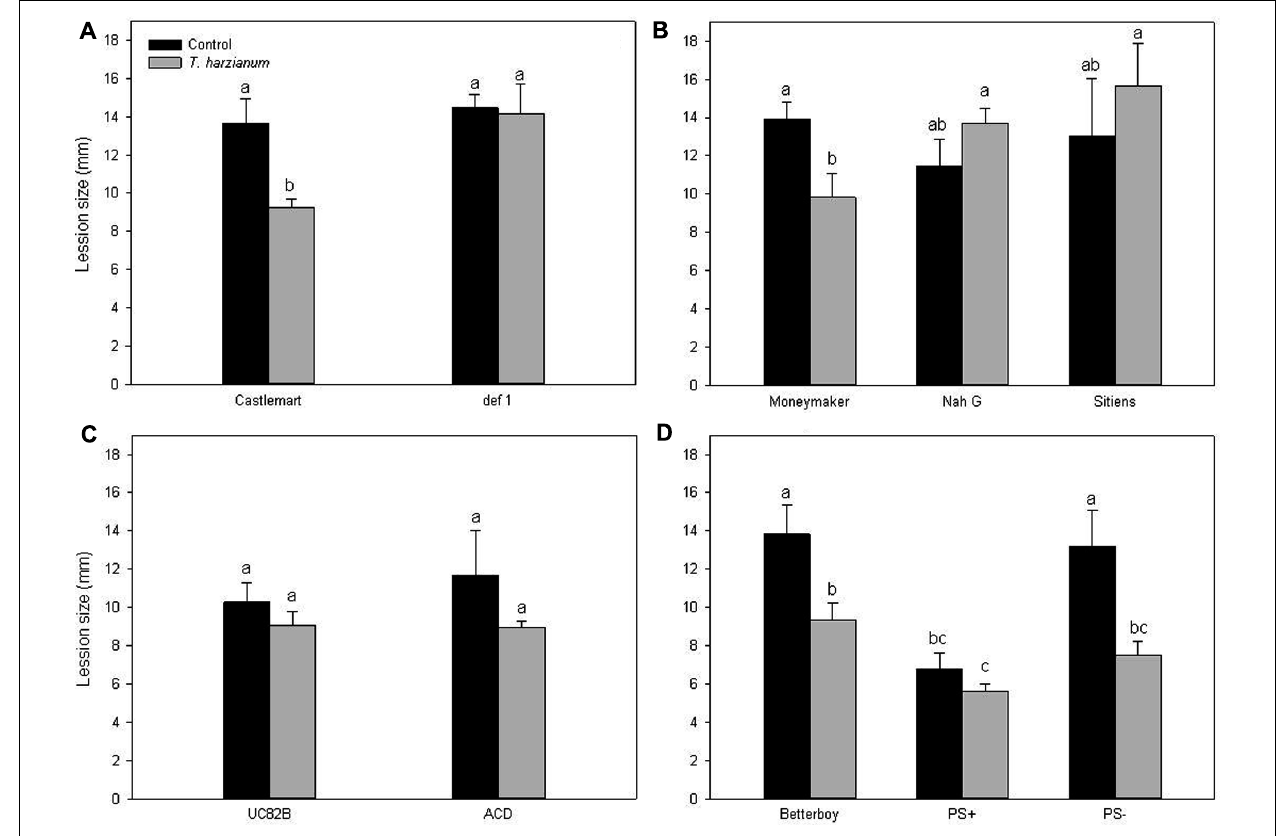
wild-type cv. UC82B and in the ET-impaired mutant ACD ; and (D ) in the wild-type cv. Betterboy and in the over-expressing mutant line PS + and the prosystemin silenced line PS − .The data show the lesion diameter (mm) ± SE ( n = 12). Data not sharing a letter in common differ significantly ( P < 0.05) according toTukey’s multiple-range